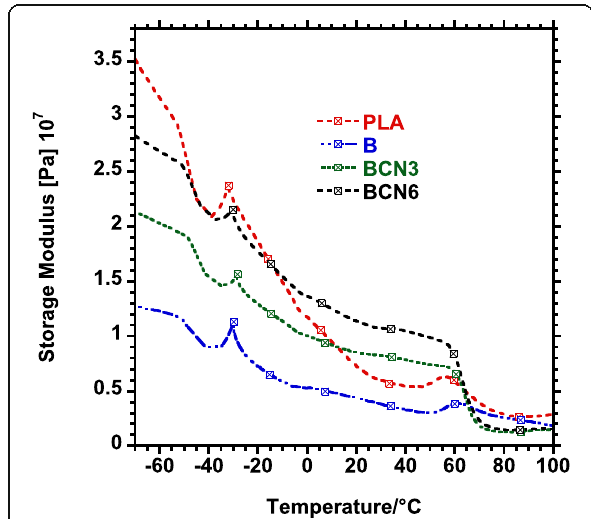
Fig. 6 Storage Modulus curve of the prepared foams